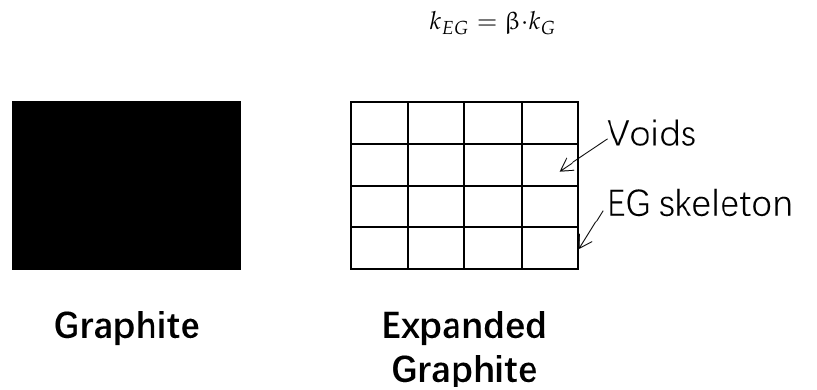
Figure 9. Thermal network variation from graphite to expanded graphite (EG).